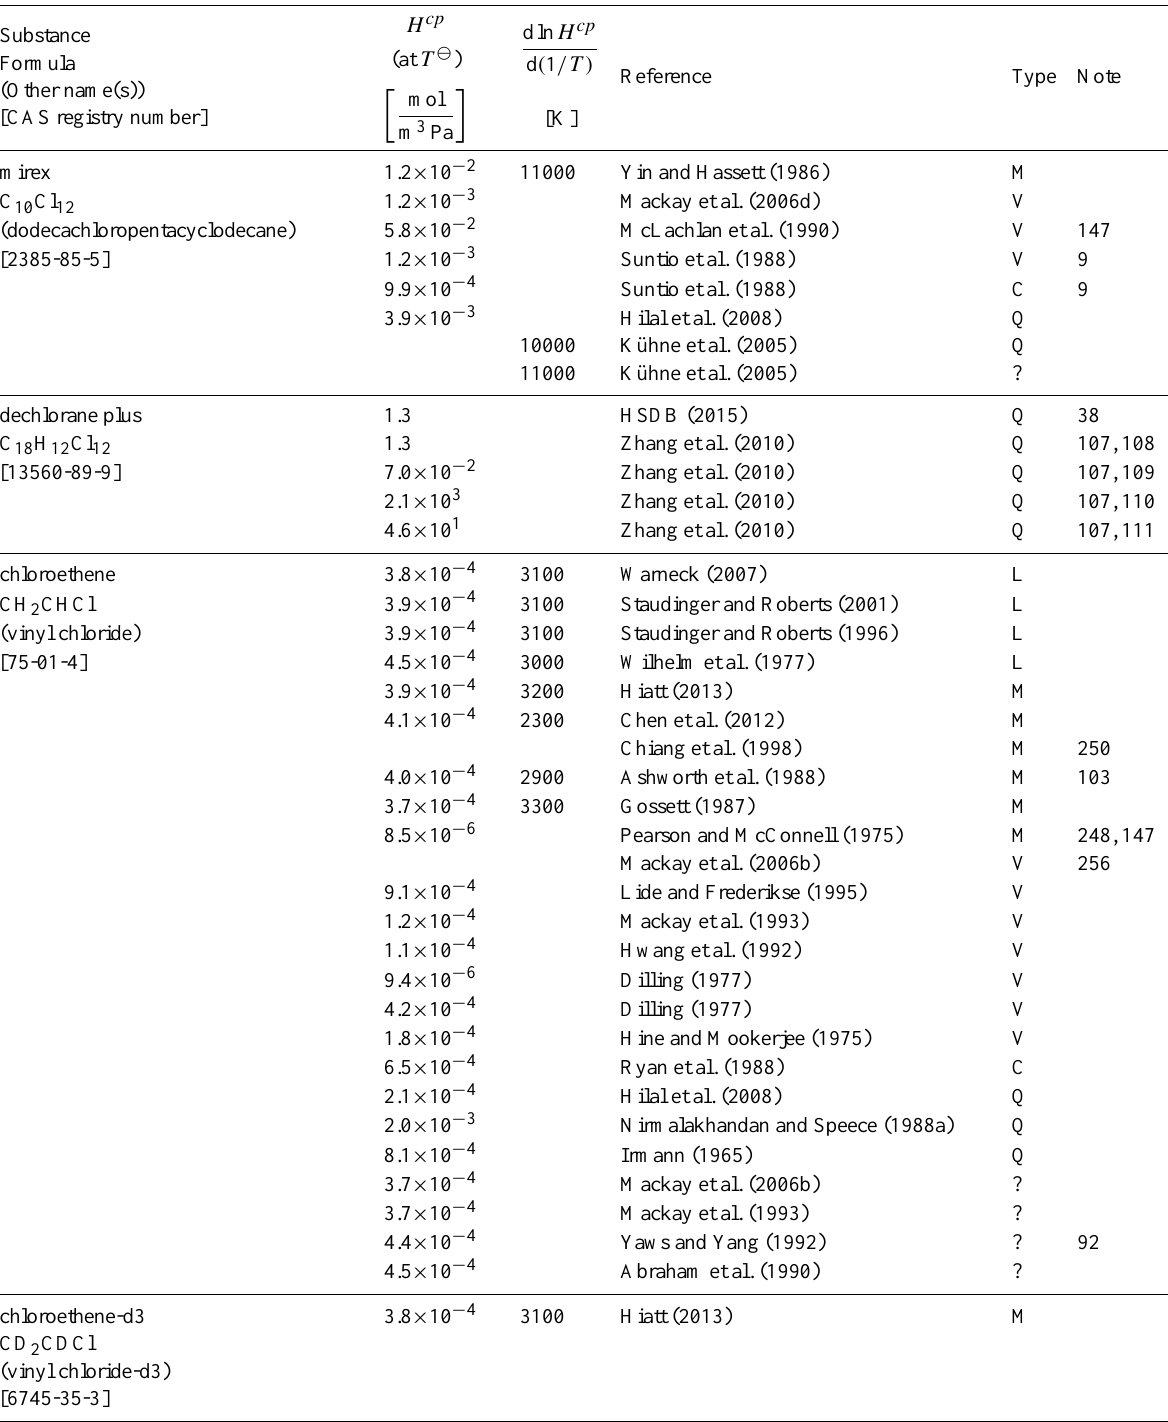
Table 6: Henry’s law constants for water as solvent